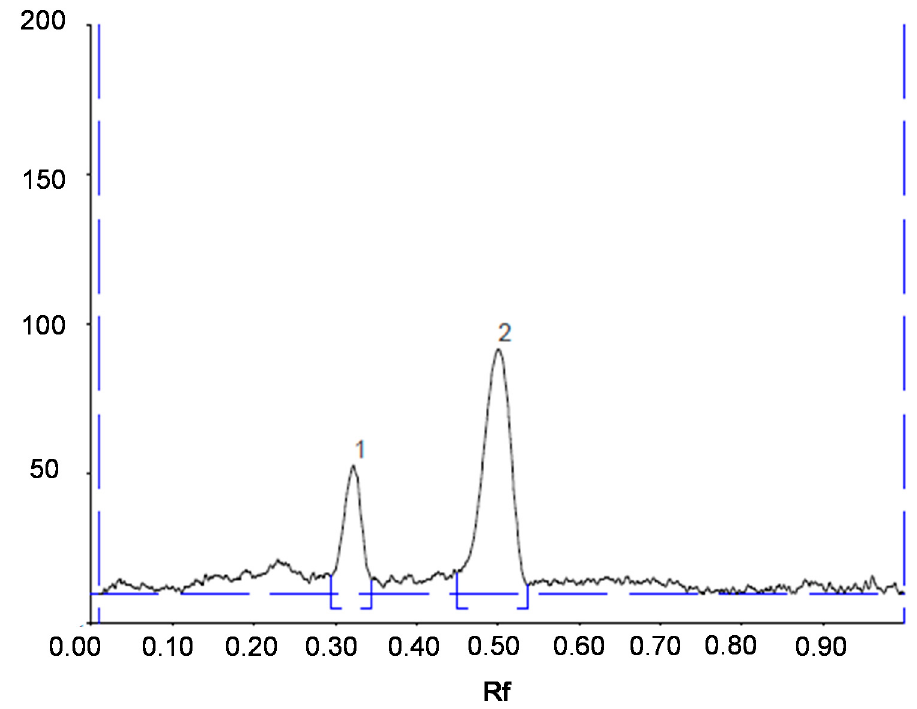
Figure 1. Chromatogram of Curcuma xanthorrhiza sample. Chromatographic conditions: mobile phase, chloroform:methanol:formic acid (94:3:3 v / v ); (1: demethoxycurcumin; 2: curcumin).